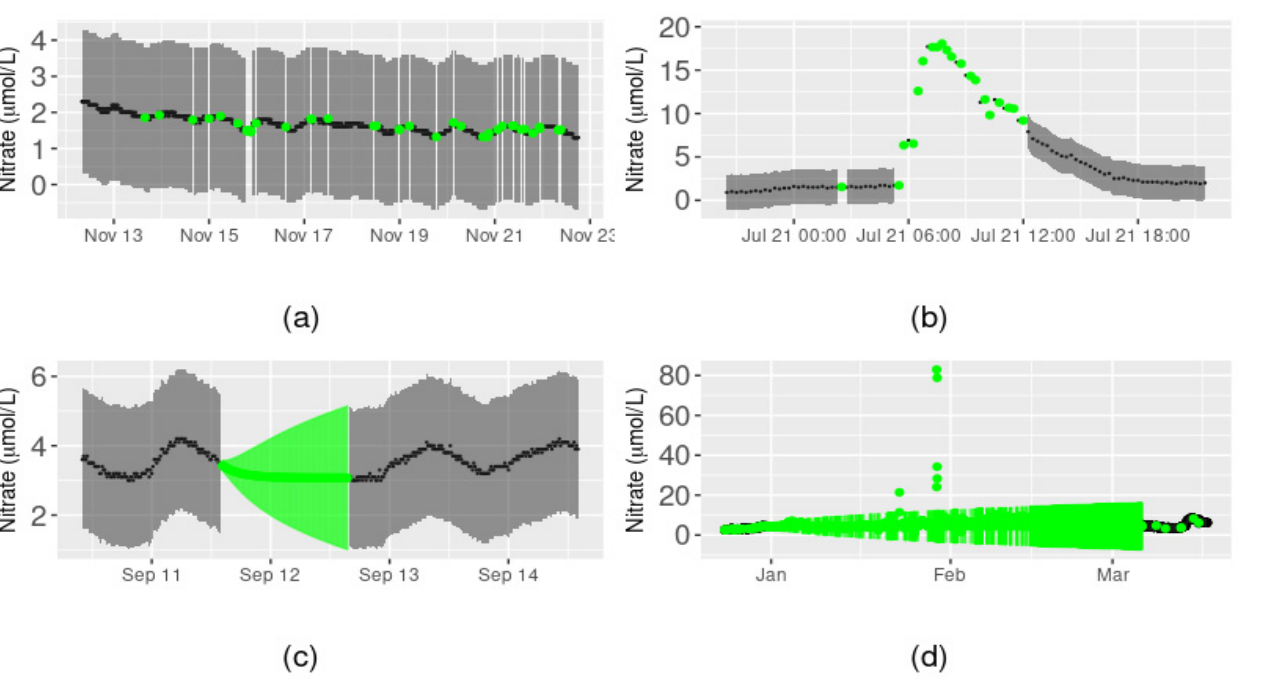
Figure 3. Reconstruction of Arikaree nitrate data. Green points represent the nitrate concentration values predicted by the reconstruction method, along with intervals of prediction, for ( a ) a 12-day sequence of sporadically missing data, ( b ) a one-day peak flow event containing sporadically missing data, ( c ) a full day of contiguously missing data, and ( d ) a three-month sequence of contiguously missing data. Black points represent the original nitrate observations, grey shading represents the precision interval of the sensor. Prediction intervals may not be visible when they are narrow relative to the precision interval of the sensor.